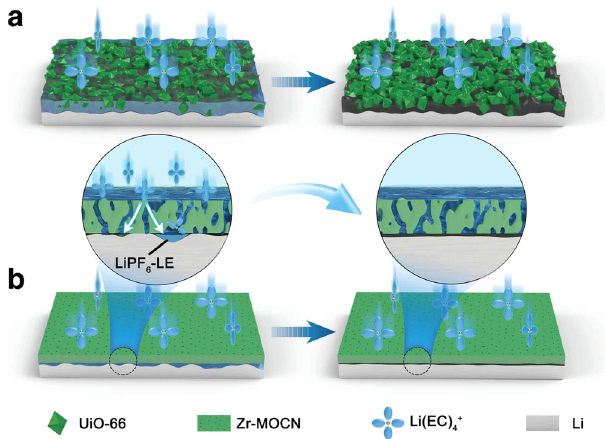
Fig. 7 Schematic illustration of the Li-deposition in cells with